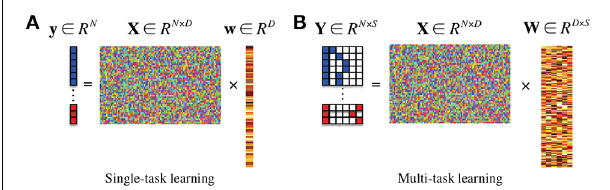
FIGURE 1 | In the response vector/matrix, the colors of blue, red, and whiterepresent1, − 1,and0,respectively. Inmulti-tasklearning,eachrowof theresponsematrixrepresentsanewlydefinedsparsecodeforeachsample by the proposed method. (A) Single-task learning, (B) multi-task learning.